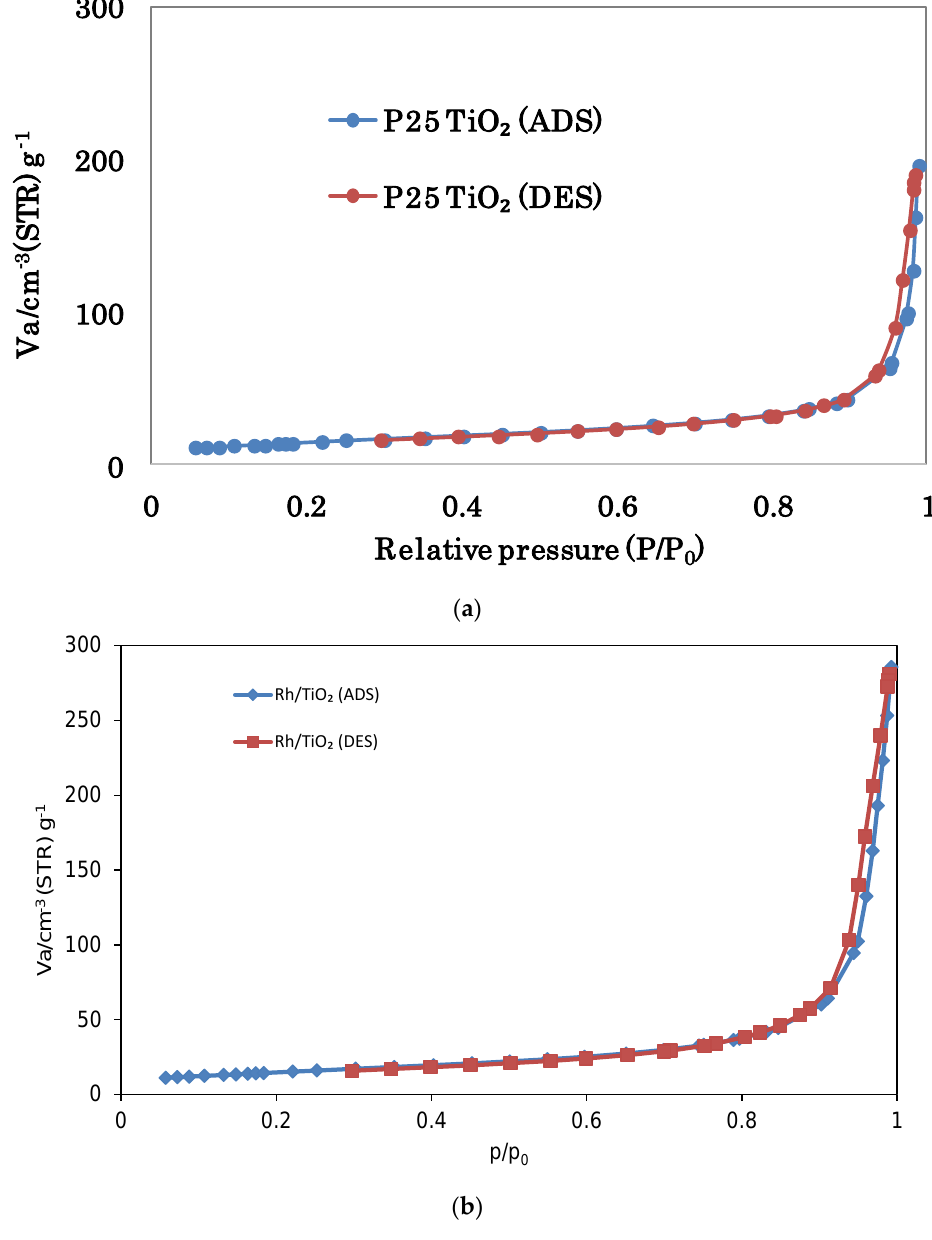
Figure 12. N 2 adsorption–desorption isotherms of ( a ) P-25 TiO 2 ( upper ) and ( b ) Rh/TiO 2 ( down